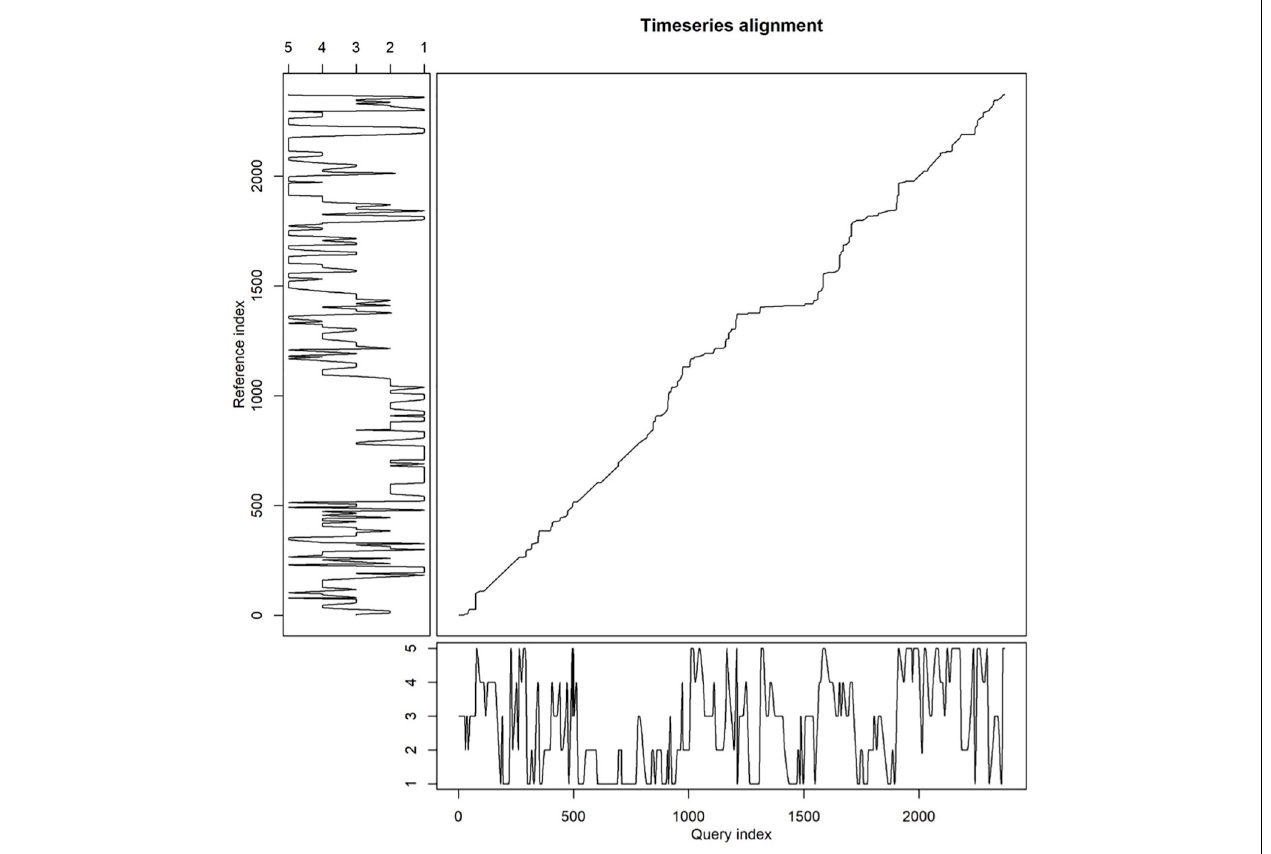
FIGURE 4 | Relative position of individuals S11e (X-axis) and M21g (Y-axis). Perfectly aligned swimming would yield a straight diagonal line from bottom left to upper right.